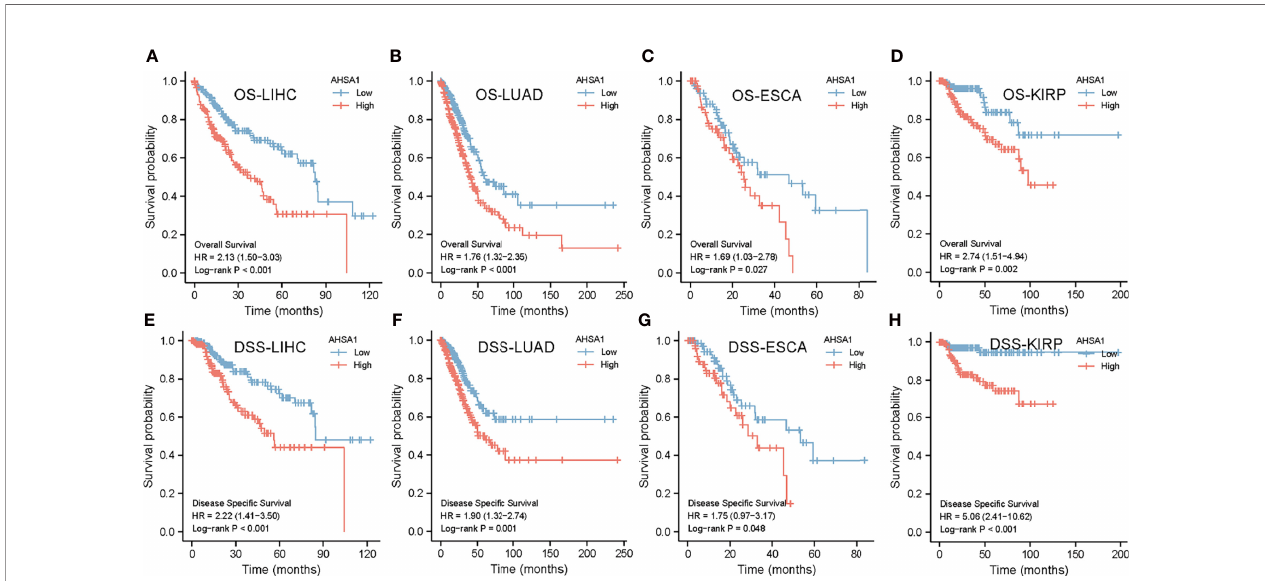
FIGURE 2 | Survival analysis of AHSA1 in pan-cancer. The effect of AHSA1 expression on the overall survival rate (OS) of LIHC (A) , LUAD (B) , ESCA (C) and KIRP (D) was analyzed by Kaplan-Meier method. Meanwhile, the in fl uence of abnormal expression of AHSA1 on disease-speci fi c survival (DSS) of LIHC (E) , LUAD (F) , ESCA (G) and KIRP (H) was calculated.